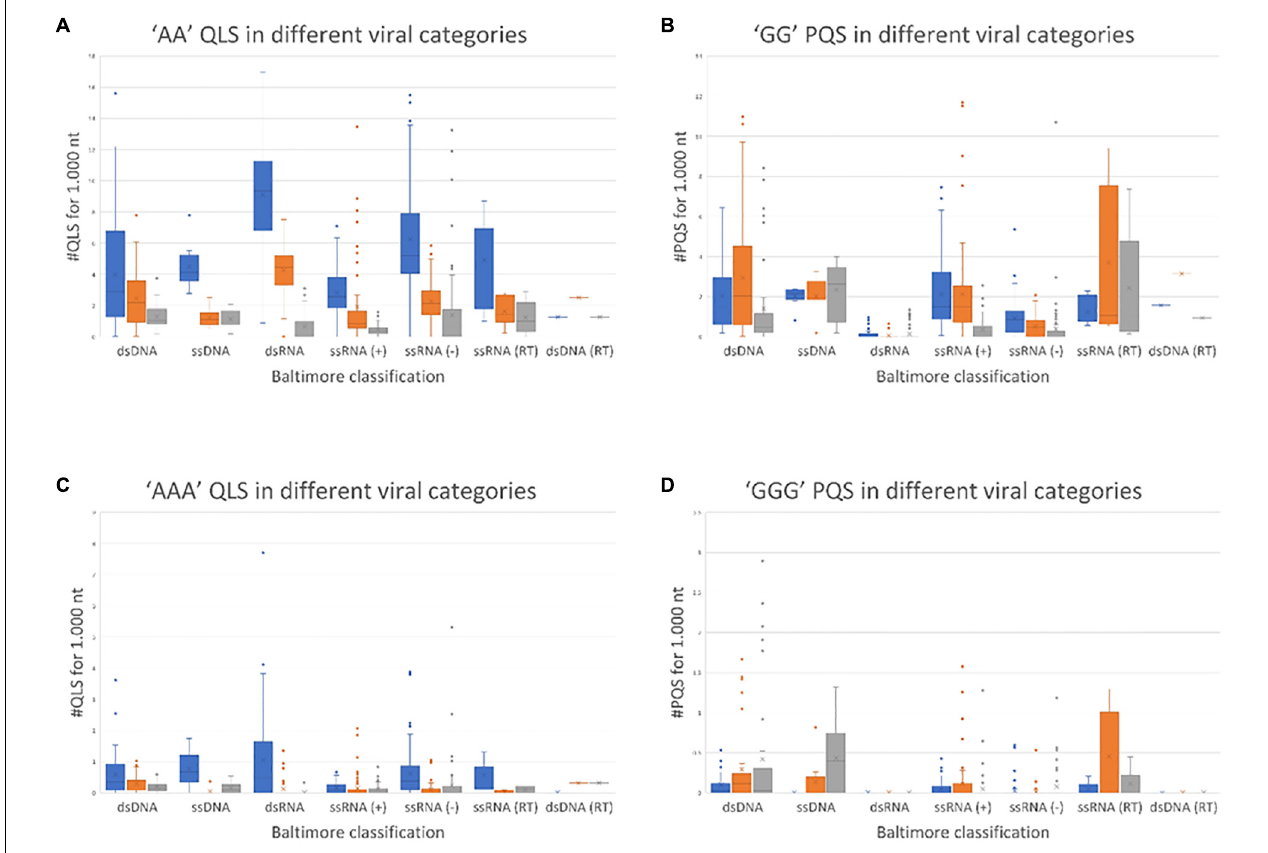
FIGURE 1 | Normalized abundance of A-QLSs (A,C) and G-PQSs (B,D) in the genome of all human viruses, grouped by Baltimore class. Each panel refers to the specified type of island (AA and AAA for A-QLSs, GG and GGG for G-PQSs); boxplots are delimited by the first and third quartile and the inside horizontal line is the median value of the QLS distribution. Whiskers delimit all the points that fall above/below the third/first quartile ± 1.5 times of the interquartile range (IQR). Bar colors indicate the strand where the predicted patterns are found with respect to coding sequences and refer to concordant (same strand of a CDS, blue), discordant (opposite strand of a CDS, orange), and non-coding (no CDS overlaps that pattern, gray),